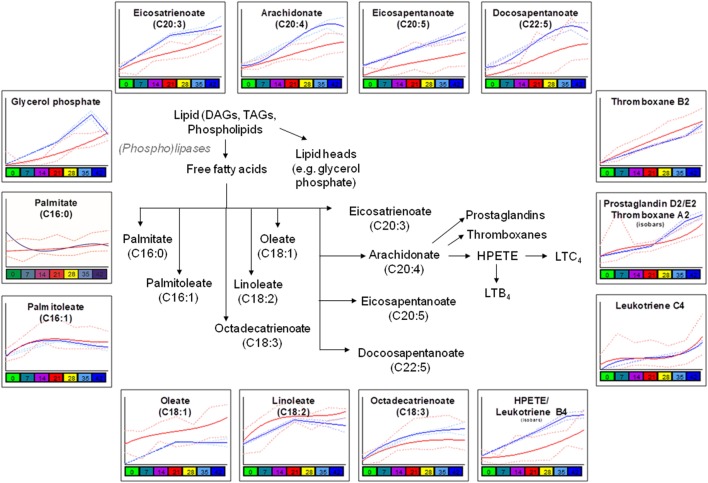
Significant differences in fatty acid metabolism and oxidation between glucose 6-phosphate dehydrogenase (G6PD) sufficient (blue line) and deficient (red line) red blood cells during storage in the blood bank (median + ranges are shown in light blue or red for both G6PD sufficient and deficient groups, respectively).